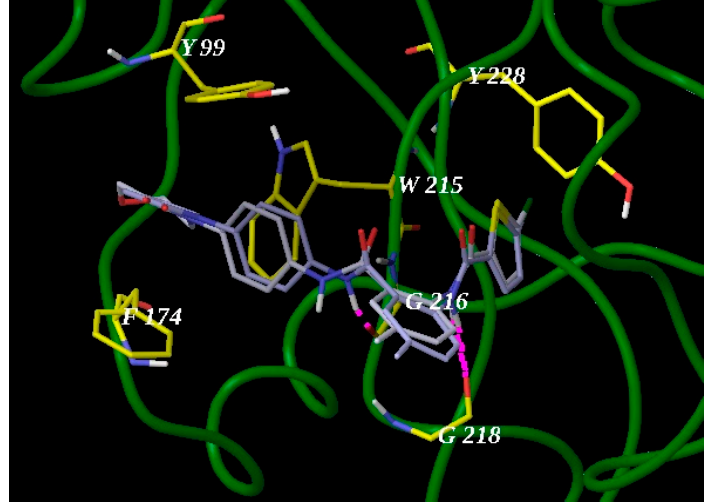
Figure 6. The interactions of compounds 1g and 1s with the active site of FXa.